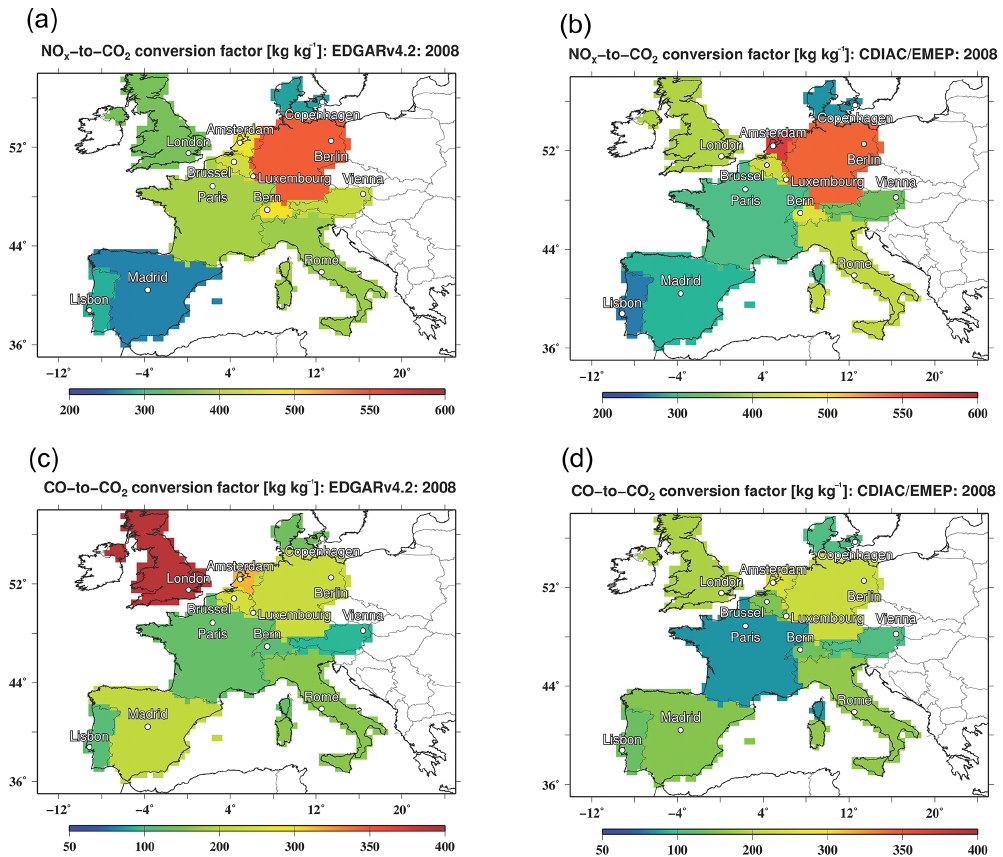
Figure 5. NO x -to-CO 2 (a, b) and CO-to-CO 2 (c, d) emission conversion factors obtained using NO x , CO, and CO 2 emission estimates from the EDGAR v4.2 emission inventory (a, c) and from the CDIAC and EMEP emission inventories (b, d) for the emission totals.